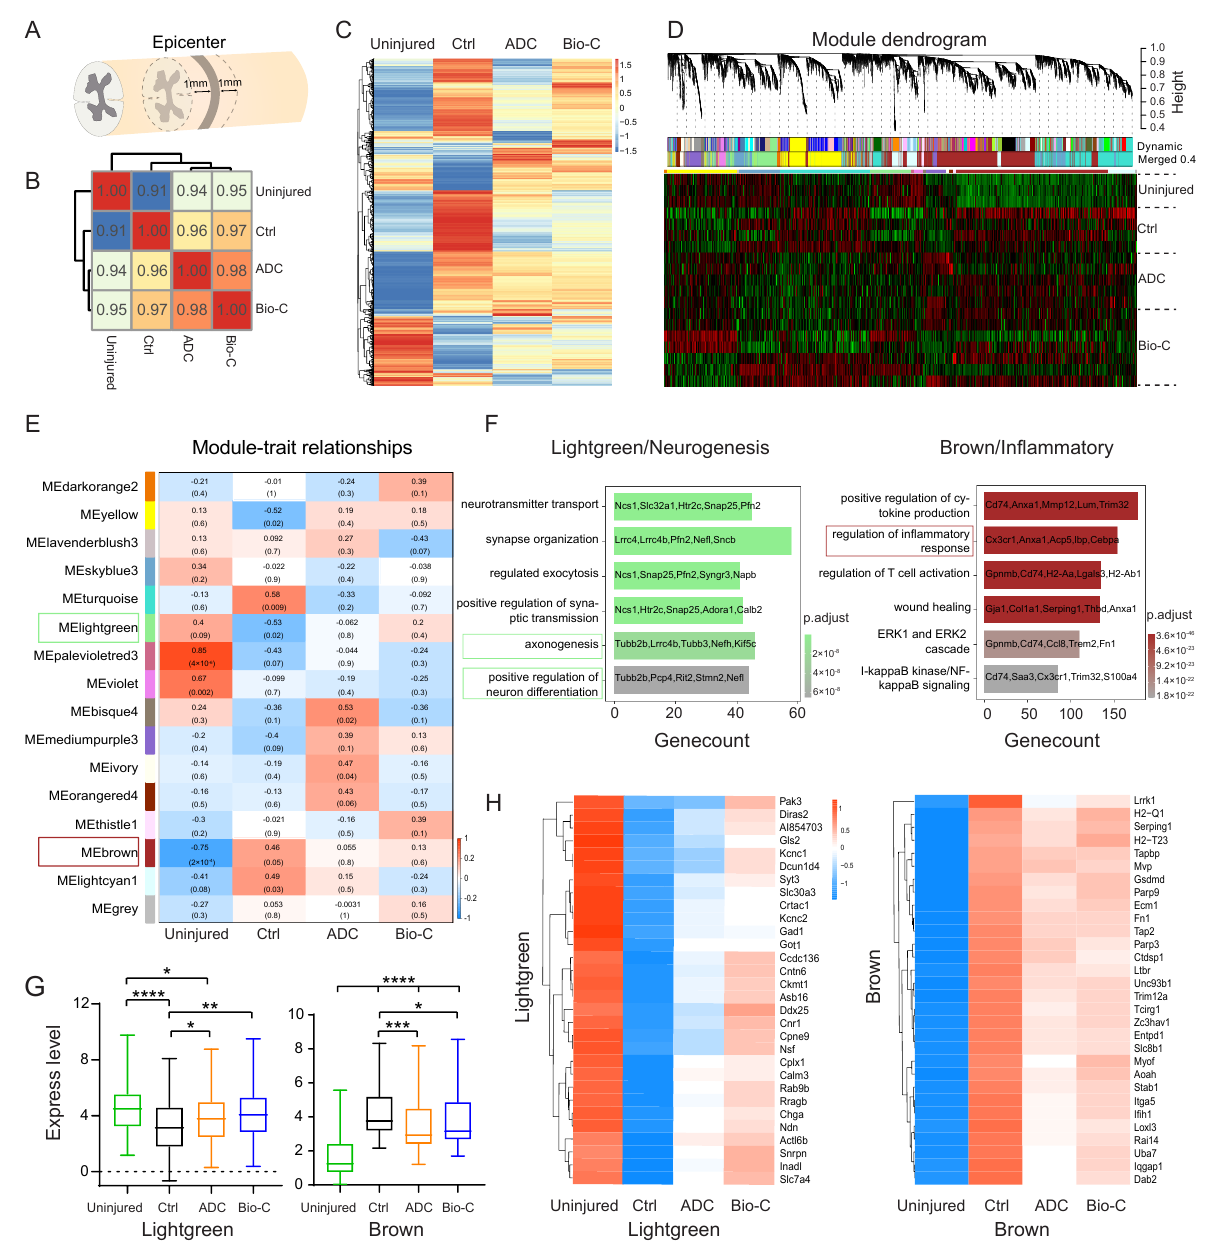
Figure 3. RNA-Seq analysis uncovered molecular mechanisms for better functional recovery in SCI mice with Bio-C implants. ( A ) Total RNA was collected from 2 mm segments of spinal cord surrounding the epicenter of the lesion. ( B ) Pairwise Pearson correlation amongst all sample groups (uninjured normal mice, injured control mice, and SCI mice with ADC or Bio-C implants). ( C ) Cluster thermogram of differentially expressed genes among sample groups (uninjured normal mice, injured control mice, and SCI mice with ADC or Bio-C implants). ( D ) WGCNA Dendritic Trees and Heatmap of significantly differentially expressed genes among sample groups before/after SCI and with the ADC or Bio-C implants. ( E ) Module–trait correlation analysis revealed dynamic changes of sixteen modules under different conditions. ( F ) GO analysis reveals the neurogenesis related “Light green” module and the inflammatory-related “Brown” module among 16 modules associated with the effect of Bio-C on SCI repair. ( G ) Box-plots of all hub genes in “Light green” module (87 hub genes) and “Brown” module (93 hub genes) (mean ± SEM, n ≥ 3; **** p < 0.0001, *** p < 0.001, ** p < 0.01, and * p < 0.05; unpaired Student’s t -test). ( H ) Heatmap of the top 30 hub genes according to “Light green” module and “Brown” module among uninjured normal mice, SCI control mice, and SCI mice with ADC and/or Bio-C